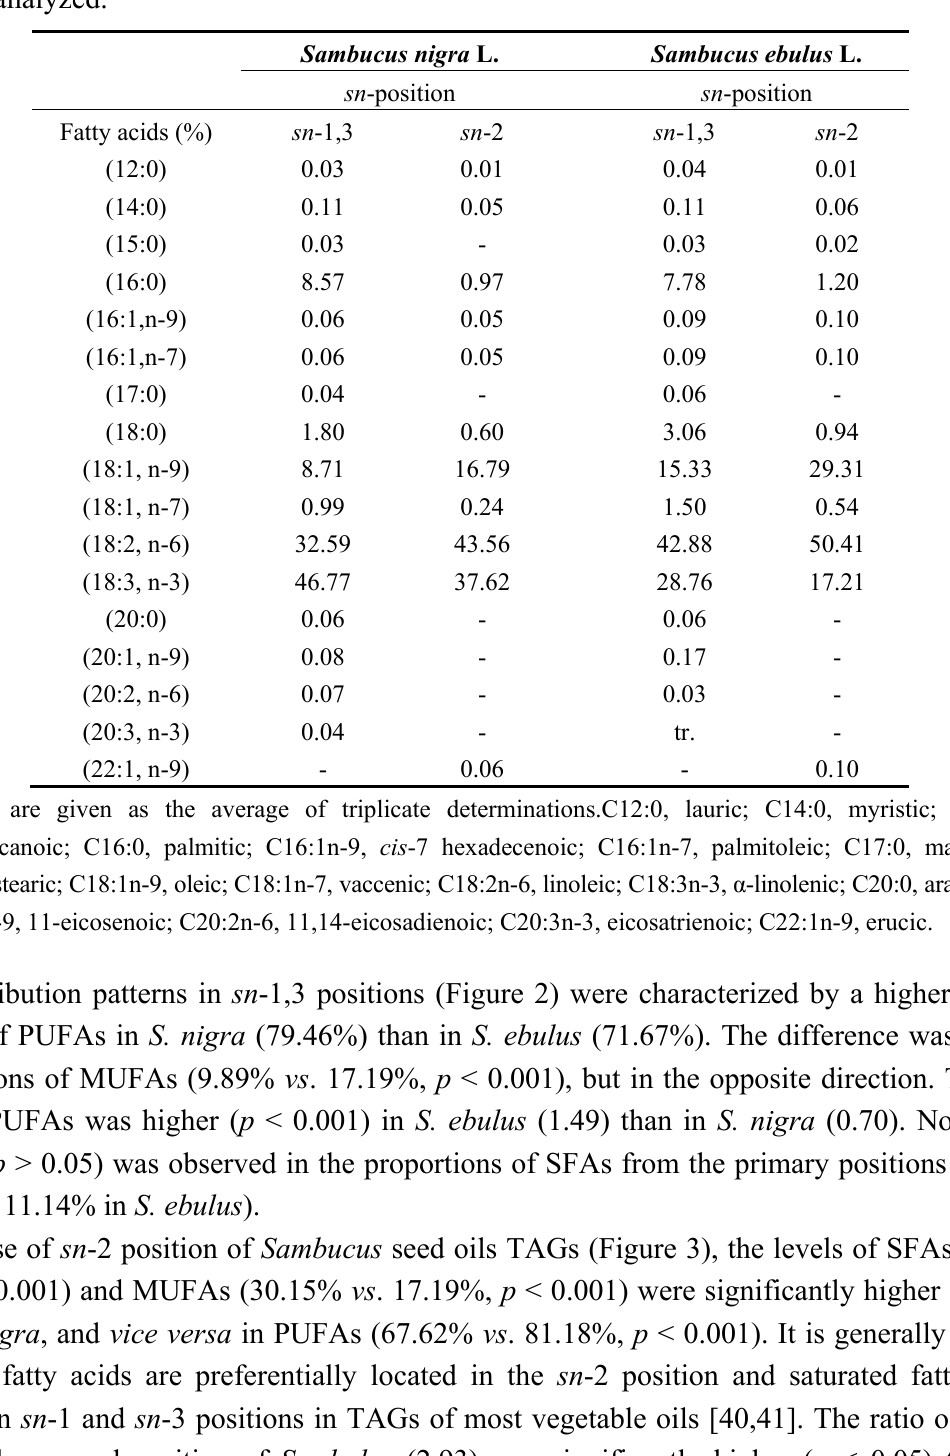
Table 3. Positional distribution (% of total fatty acids) of fatty acids in TAGs of Sambucus seed oil samples